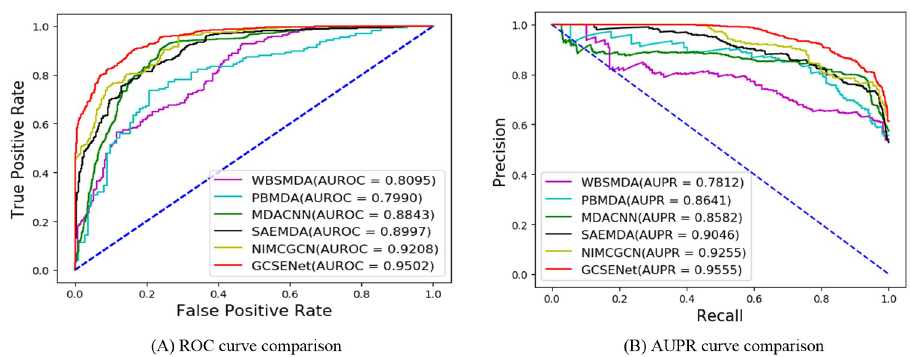
Fig 6. Comparison of different ROC and AUPR curves in miRNA-disease association prediction.